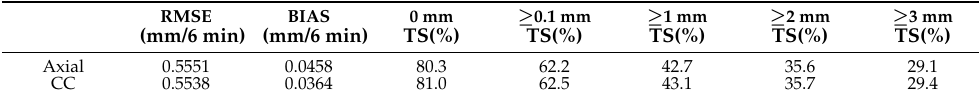
Table 10. Comparison of axial attention and criss-cross attention (CC). RMSE